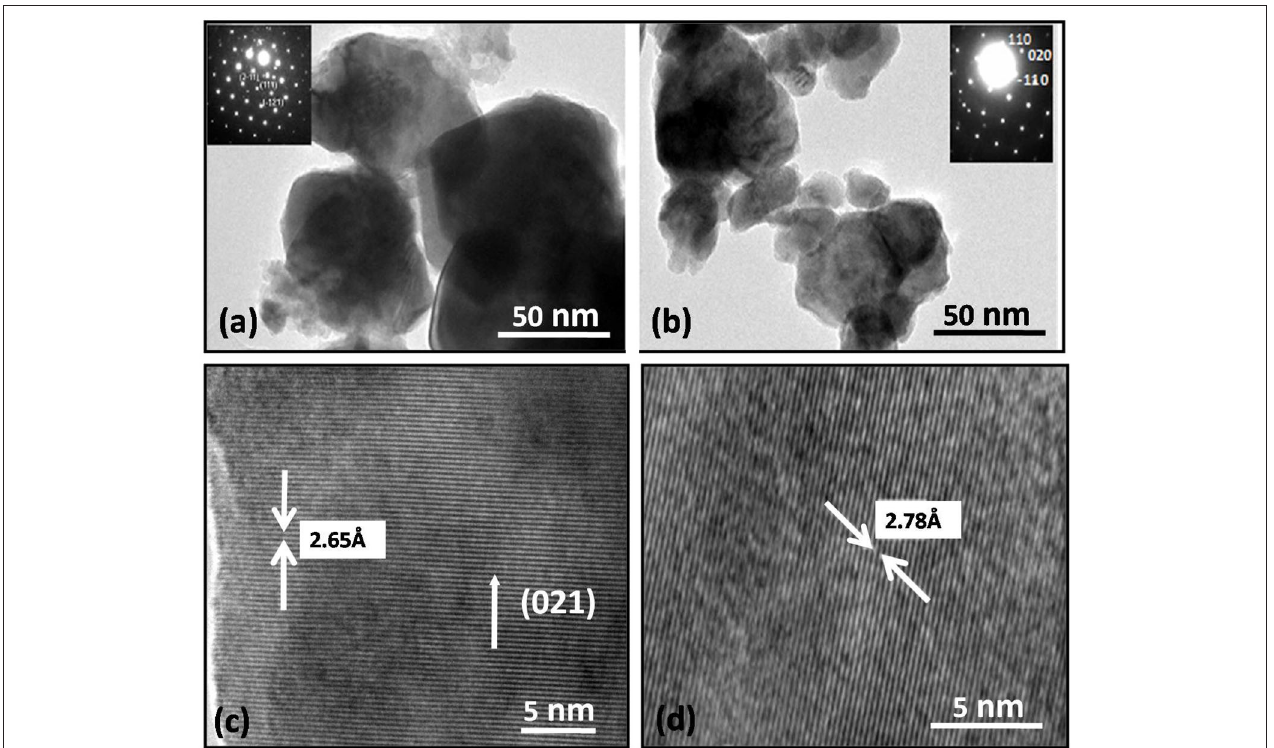
FIGURE 4 | TEM images of Bi 1 La x Fe 1 Ni y O 3 : (a) x 0.0, y 0; (b) x 0.20, y 0. Inset in (a,d) shows SAED pattern for rhombohedral (c,d) HRTEM images of = = = = − x − y Bi 1 La x Fe 1 Ni y O 3 ( y 0.0 and 0.10 with x 0.20, for = = − x − y